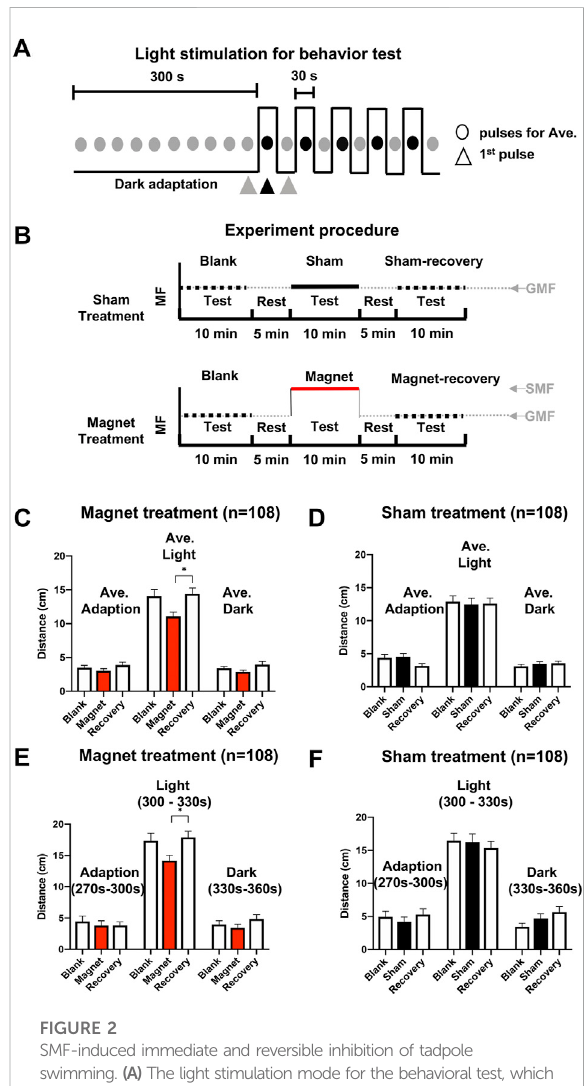
FIGURE 2 SMF-induced immediate and reversible inhibition of tadpole swimming. (A) The light stimulation mode for the behavioral test, which includes a 300 seconds (s) adaption in the dark and 5 pairs of light-dark pulses. Each circle represents 30 s, black and gray represent a stimulation in the light and an adaptation in the dark, respectively. Trianglesrepresentthelast30softhedarkadaptationperiod(270 – 300 s) andthe fi rstlightpulse:the30 slightstimulationperiod(300 – 330 s),and the dark period (330 – 360 s), respectively, for data analysis. (B) The experimental procedure for sequential tests under blank, sham, or magnetic,andblank(recovery)conditions.Thehorizontalaxisrepresents test/rest time. The vertical axis represents the relative magnetic fi eld strength of different treatment conditions. The black dotted line represents the relative magnetic fi eld strength without a nickel/magnet during the test. The black and red lines represent the relative magnetic fi eldstrengthwiththepresenceofanickelorthemagnetduringthetest, respectively.A “ test ” meansacompletelocomotionobservationbyusing the light stimulation mode described in panel (A) (C,D) Effect of the SMF (C) and sham (D) treatments on the average swimming distance of tadpoles. (E,F) Effect of the SMF (E) and sham (F) treatment on the swimming distance of tadpoles in the last 30 s of the dark adaptation period (270 – 300 s), the 30 s light stimulation period (300 – 330 s), and the dark period (330 – 360 s). n is the total number of tadpoles from six experiments, eighteen tadpoles per experiment. Data are expressed as mean±SEM.The p valueswerecalculatedusingtheKruskal –